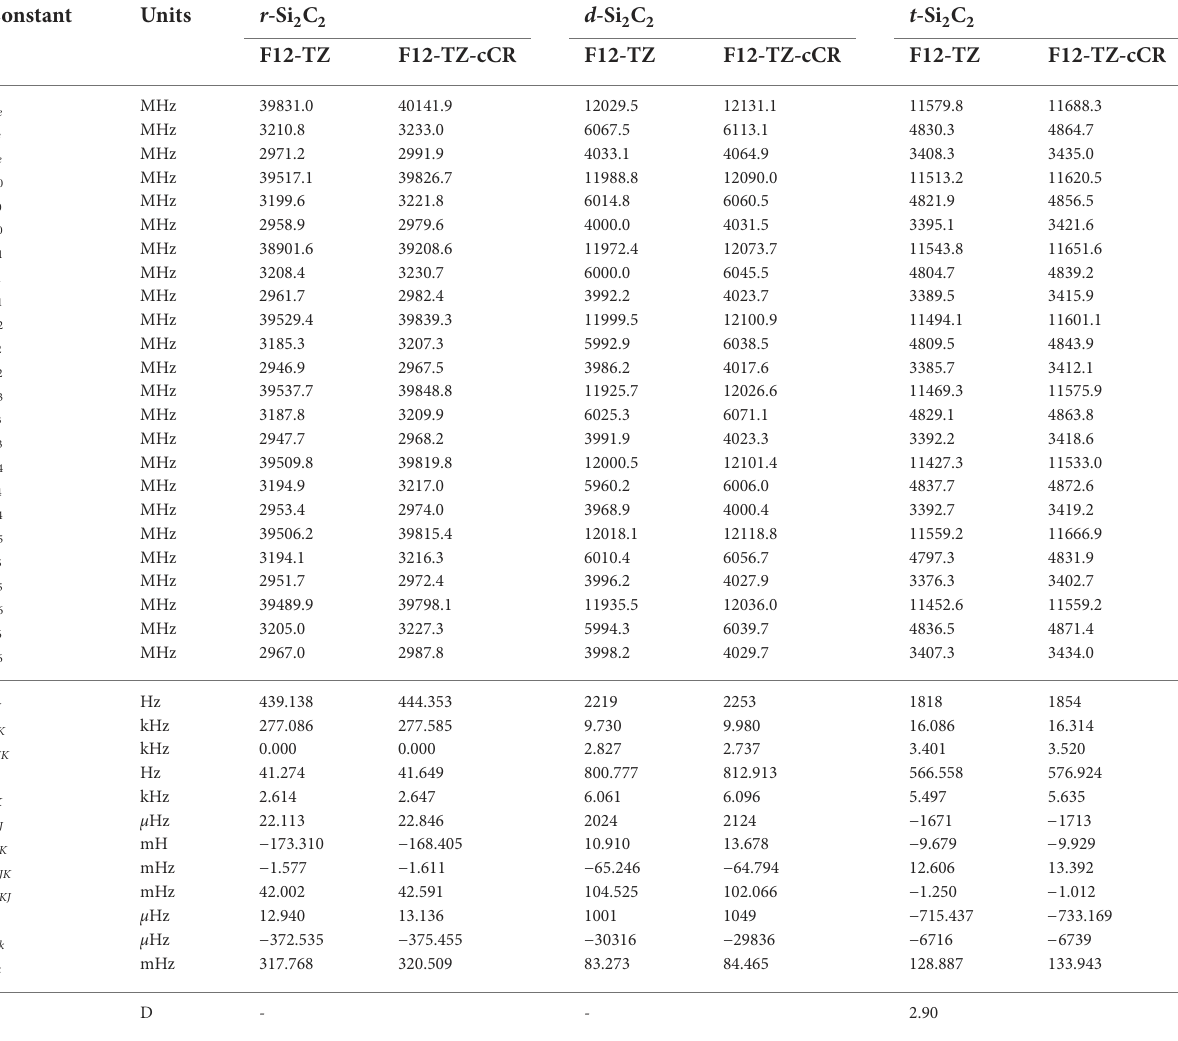
TABLE 6 Equilibrium( e ),vibrationally-averaged( 0 ),andsingly-vibrationallyexcited( n >0 )principalrotationalconstants,quartic( Δ / δ )andsextic( Φ / ϕ ) distortionconstants,anddipolemoments ( μ ) forSi 2 C 2 Isomers.